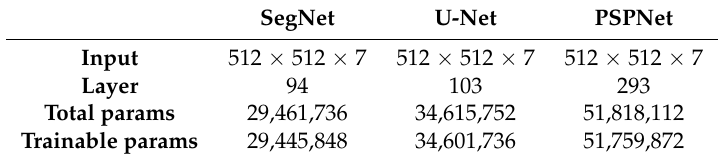
Figure 16. Typical results of a traditional multi-resolution segmentation method and two deep-learning- based semantic segmentation methods used in this study. Table 2. The parameters of each semantic segmentation method learned in this